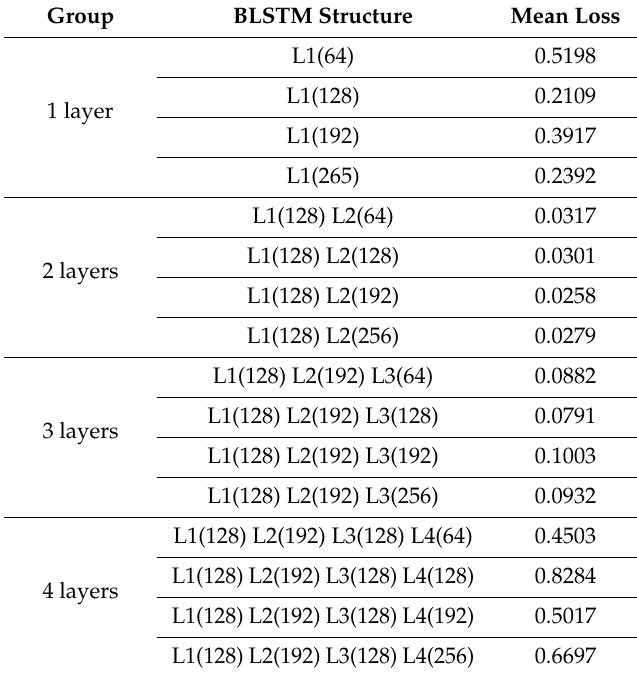
Table 5. Mean final losses of each BLSTM